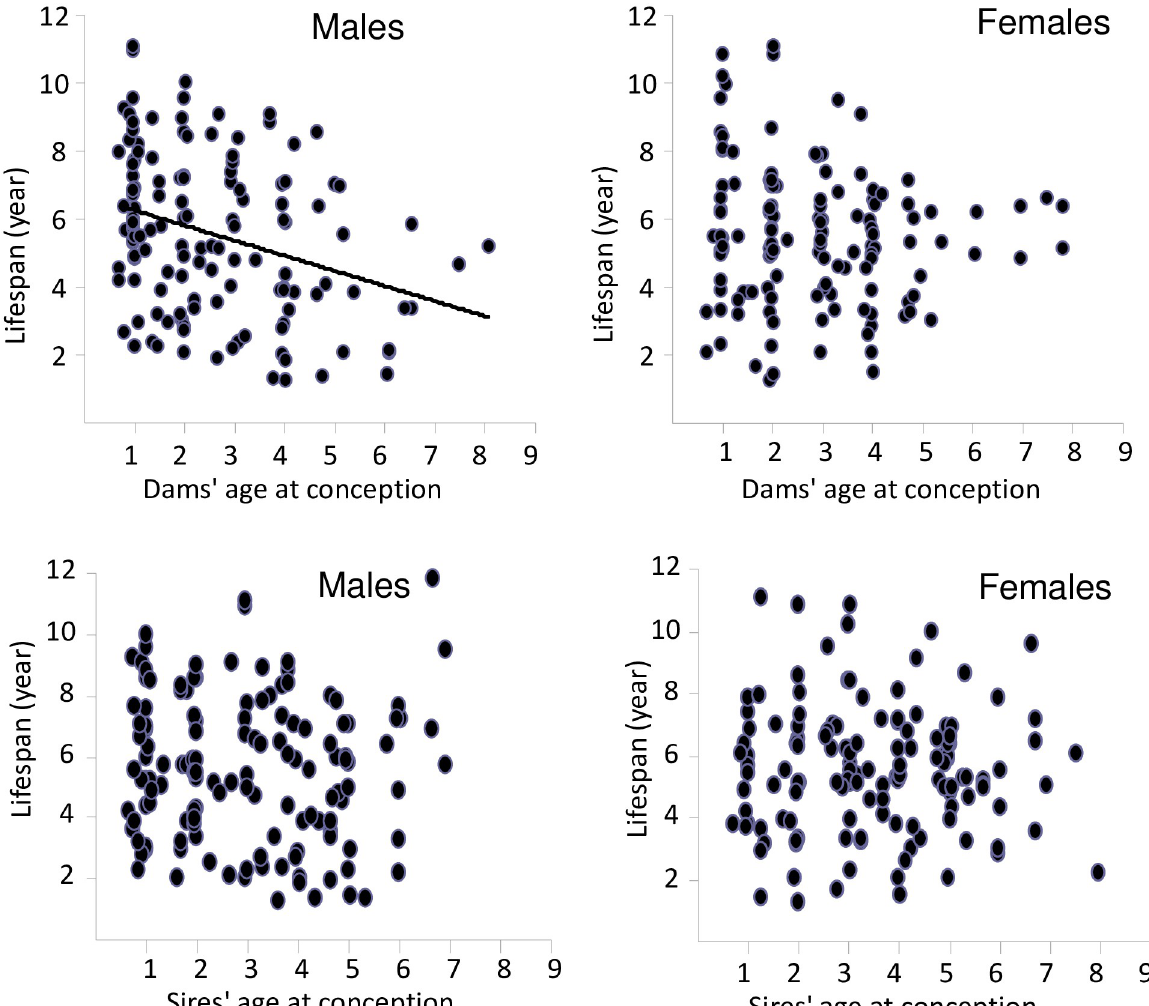
Fig 2. Relationship between offspring longevity in males (left panel) and females (right panel) according to the age at conception of dams and sires. Only, a significant correlation was observed between age at conception of dams and longevity in male offspring (r = —0.309, P <